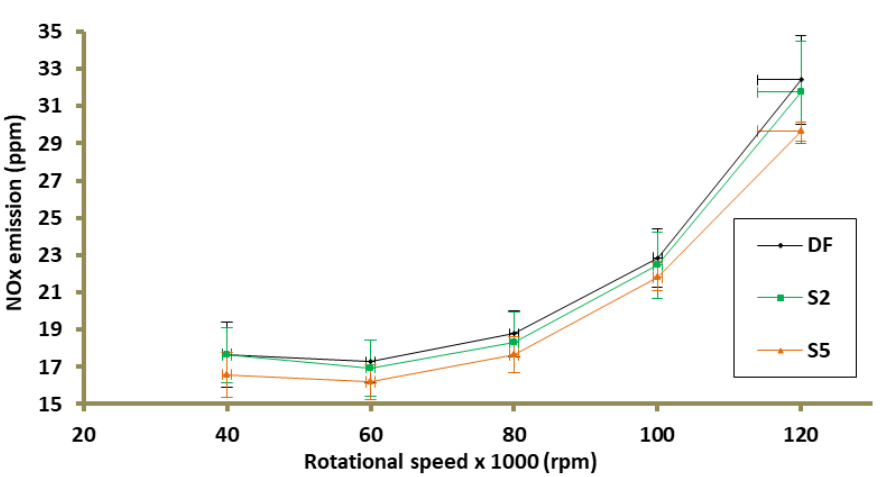
Figure 7. NOx emission depending on the rotational speed.